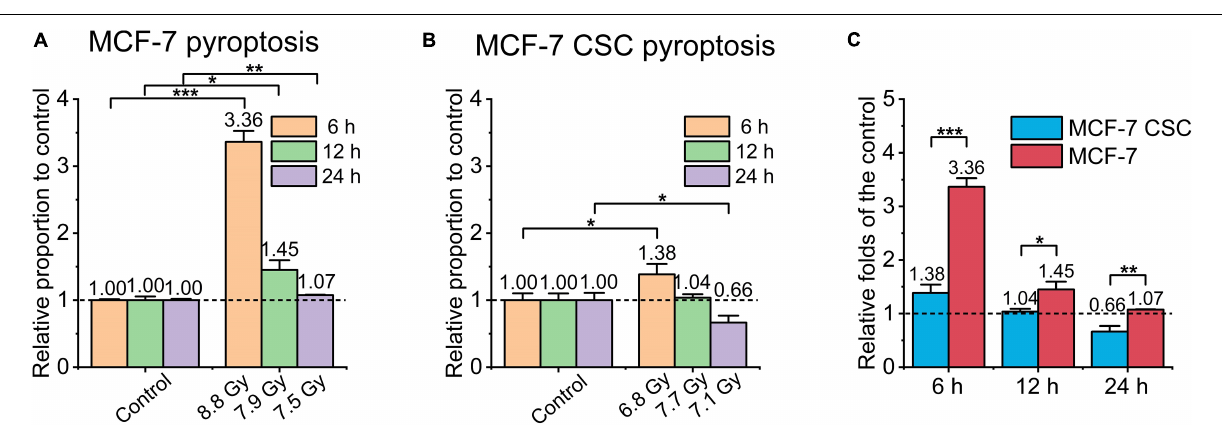
FIGURE 4 | Pyroptosis of irradiated MCF-7 cells and MCF-7 CSCs. (A,B) Compared with the relative controls, the increasement of pyroptosis proportion for irradiated groups at 6, 12, and 24 h, respectively. (C) The increasement of the pyroptosis proportion between irradiated MCF-7 cells and MCF-7 CSCs. * P < 0.05; ** P < 0.01; *** P <